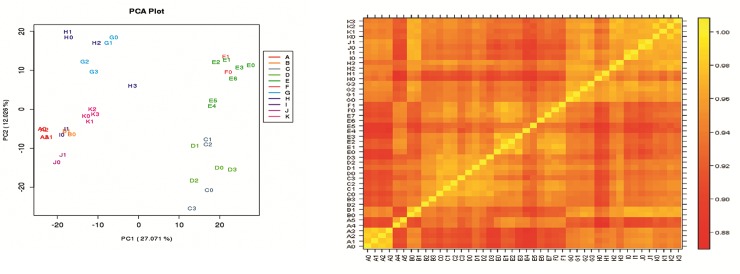
A Principal Component Analysis (PCA) to assess the variation among all samples under study. PCA was done on log10FPKM values to assess sample similarity in each group and to identify outlier samples. (Tools: Base package of R). The alphabets in the plot indicate study groups. The proportion of the variance explained by the principal components is indicated in parentheses. The study groups are: A = NPR-controls, B = PR-1-controls, C = PR-2-controls, D = PR-3-controls, E = NPR-acute, F = NPR-conv, G = PR-2-acute, H = PR-3-acute, I = PR-1-SC, J = PR-2-SC and K = PR-3-SC. All the samples within groups are intact and there are no outliers. (Data for the first trimester i.e., groups B and I is not included in the present study). Fig 1B Correlation Plot of all samples under study. Correlation analysis was performed on log10FPKM values. The plot shows the pair-wise Pearson's correlation coefficients between the expression values of the samples. Pairs of samples coming from the same group showed high correlation values (Tools: Lattice package of R). The alphabets in the plot indicate study groups. The scale bar indicates Pearson's correlation coefficients.The study groups are: The study groups are:(A):NPR-control, (B):PR-1-control, (C):PR-2-control, (D):PR-3-control, (E):NPR-acute, (F):NPR-conv, (G):PR-2-acute, (H):PR-3-acute, (I):PR-1-SC, (J):PR-2-SC and (K):PR-3-SC. All the samples within groups are intact and there are no outlier samples. (Data generated from groups B and I is not included in this study).